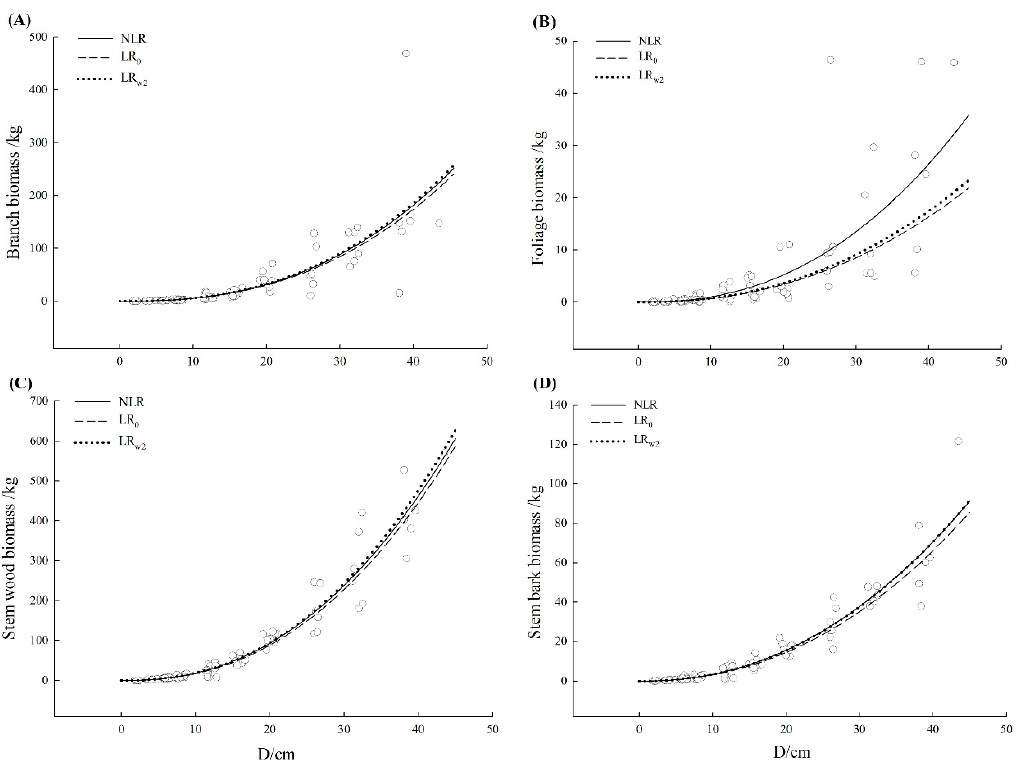
Figure 4. The curve fitted from nonlinear regression (NLR), uncorrected linear regression (LR 0 ) and corrected linear regression based on the weighted average of secondly basic correction factor from each component equation that is CF w2 ((LR w2 ) for Liquidambar formosana ( Liquidambar formosana Hance ). The scattered points were the observations from data. ( A – D ) represented branch, foliage, stem wood, and stem bark, respectively. The solid line represented the nonlinear regression model (NLR), the dashed line represented the uncorrected linear regression model (LR 0 ) and the dotted line represented the corrected linear regression based on the weighted average of secondly basic correction factor from each component equation that is CF w2 (LR w2 ).